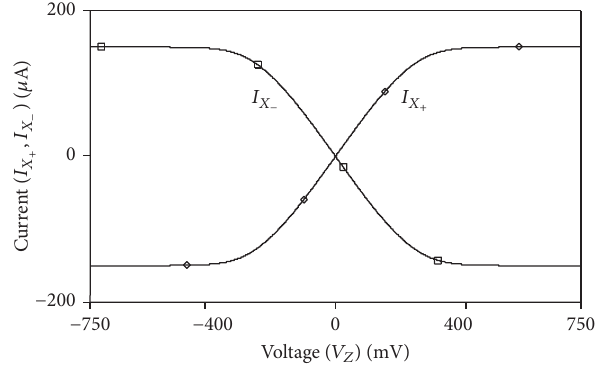
Figure 6: The DC transfer characteristics of the VDTA.